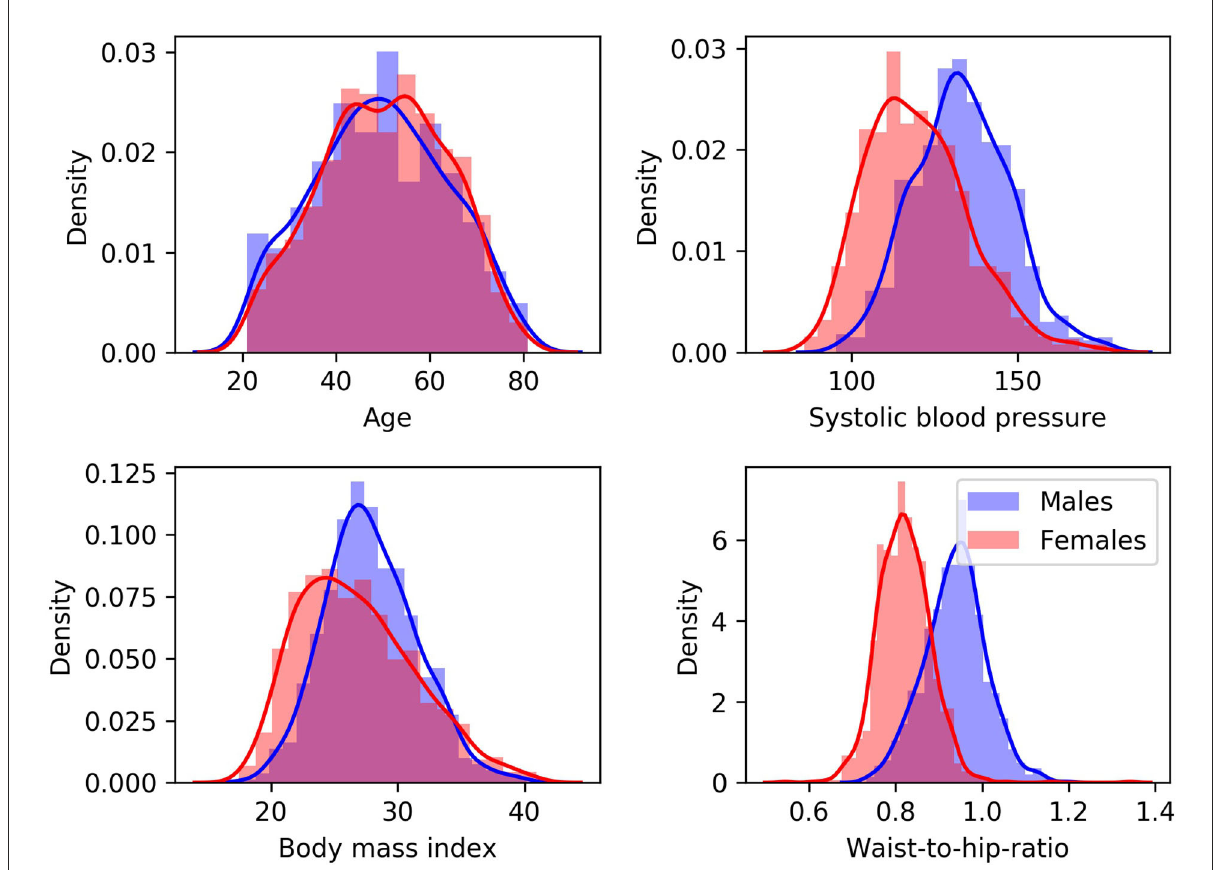
FIGURE1 Density plots for males (blue) and females (red) for cardiovascular risk factors with continuous